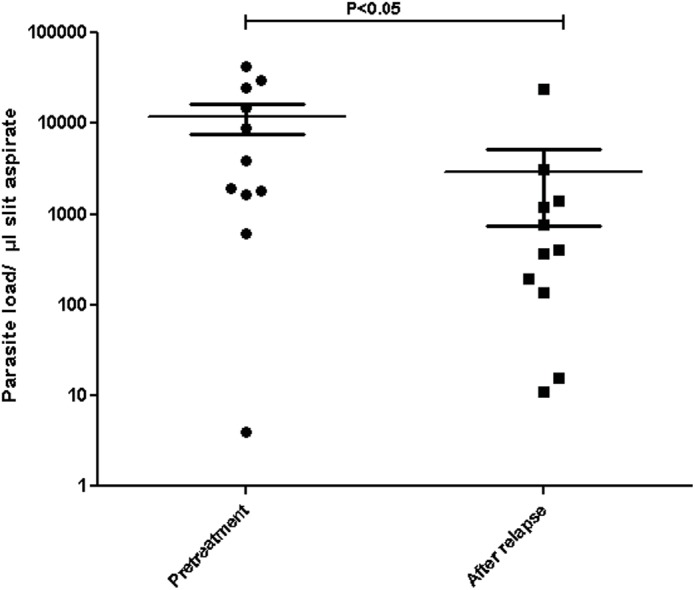

In vitro MIL susceptibility of parasite isolates from cured (n = 7) and relapsed (n = 6) PKDL patients.MIL susceptibility at (A) promastigote stage (B) amastigote stage. Each individual value represents mean IC50± SD of the results from two separate assays. P value was calculated using Mann-Whitney test. Horizontal bars indicate mean ±SEM.